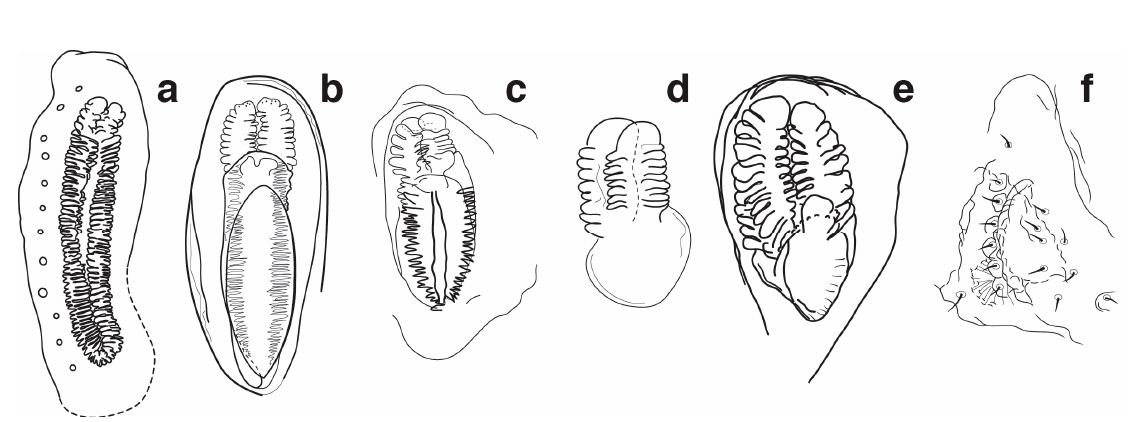
Figure 10. Thoracic spiracles, larva: ( a ) Cosmopolites sordidus ; ( b ) Metamasius ritchie ; ( c ) Phacecorynes zamiae ; ( d ) Nephius (= Anius ) pauperatus ; ( e ) Trochorhopalus strangulatus ; and ( f ) Rhynchophorus palmarum .